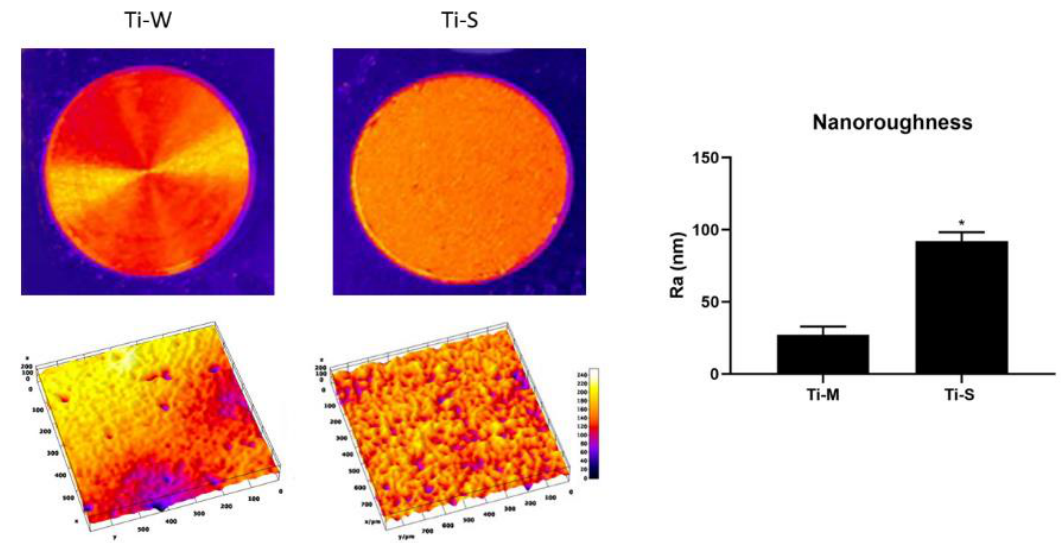
Figure 2. Macroscopical and microscopical 3D reconstruction and nano-analysis of Ti-M and Ti-S discs. The macroscopical and microscopical 3D reconstructions were obtained using ImageJ Software, starting from a photograph of the discs and SEM images at 295×, respectively. The nanoroughness measurements were obtained from AFM observations. The statistical analysis of the roughness average (Ra) expressed in nm evidenced that the roughness for the sandblasted/dual-etched surfaces (Ti-S) is higher with respect to the machined surface (Ti-M), (*denotes statistically significant differences between machined and sand-basted/dual-etched group, p < 0.001).